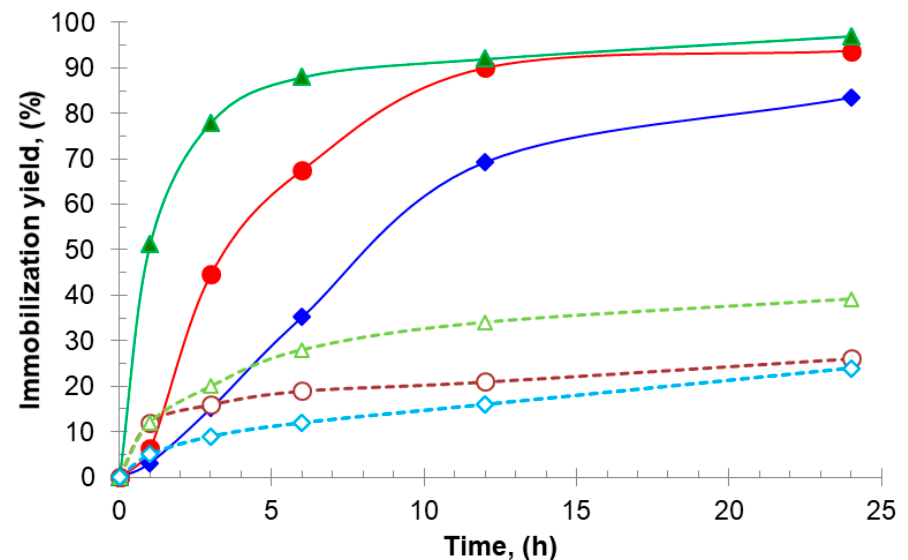
Figure 1. Immobilization progress of aminated lipases on glyoxyl–agarose support at 25 °C and pH 7.0: TLL without additives ( ▵ ) and with AA 20 mM ( ▴ ); BTL2 without additives ( ○ ) and ( ● ) with AA 20 mM; CAL without additives ( ◊ ) and with DTT 20 mM ( ♦ ).